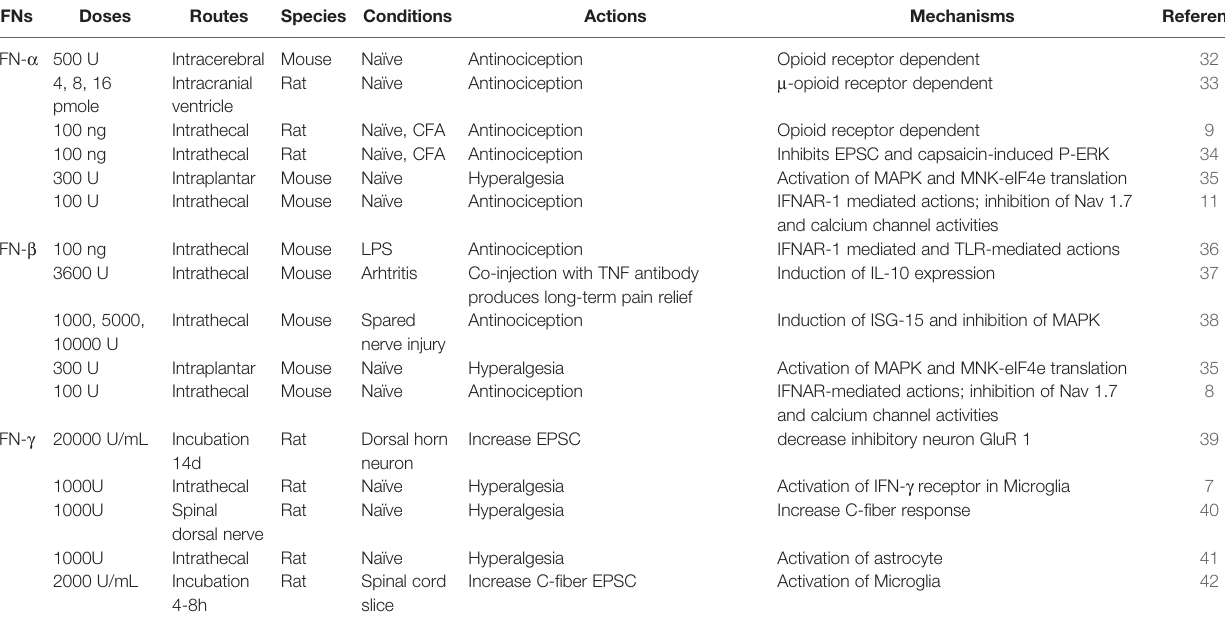
TABLE 1 | Role of IFN- a , IFN- b , and IFN- g in pain and the underlying mechanisms.